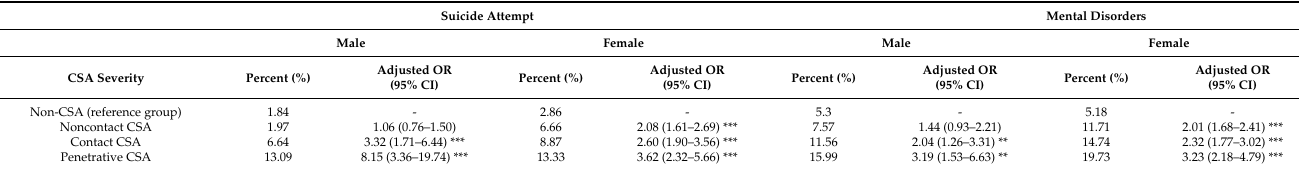
Table 3. Association between mental health and different types of CSA among respondents, stratified by sex ( n =